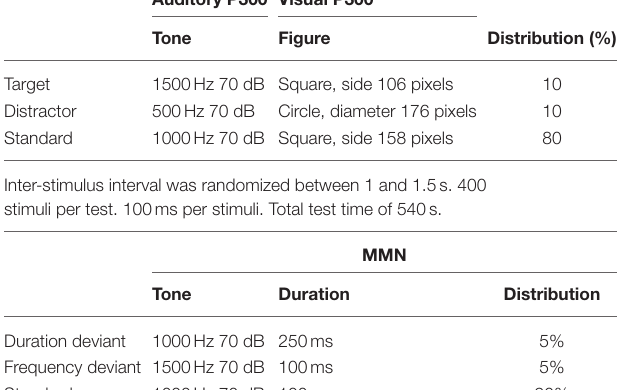
TABLE 2 | Paradigms and procedures (Laton et al., 2014).